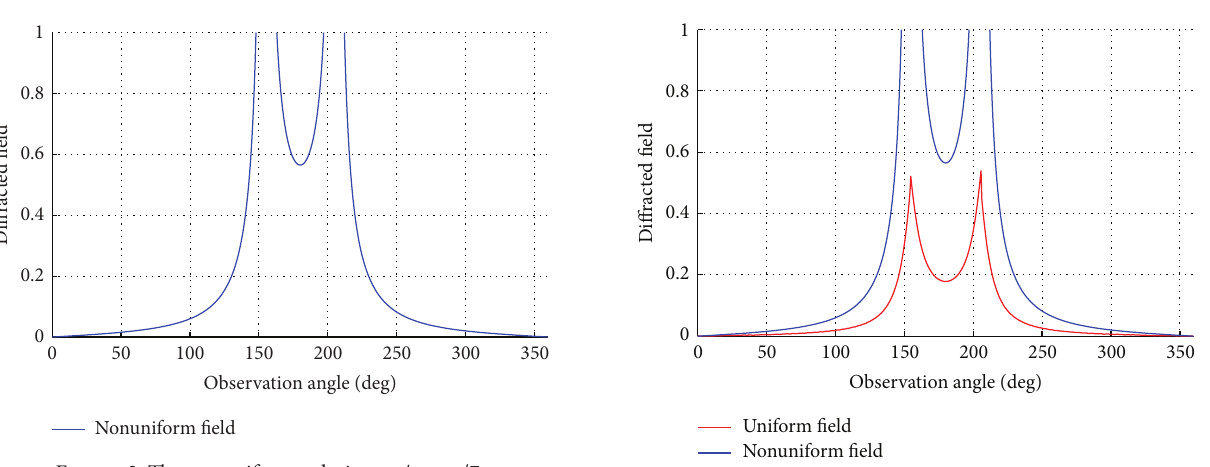
Figure 4: The nonuniform and uniform solution at 𝜙 0 = 𝜋/7 .